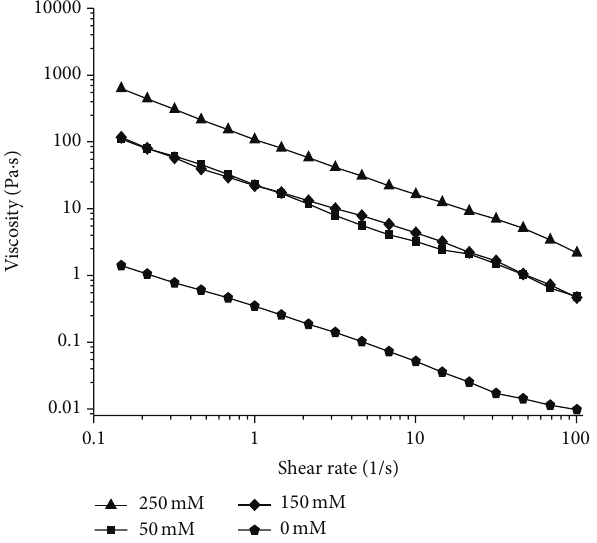
Figure 3: Steady shear flow curves of 5% LP with different concentration of Ca 2+ .